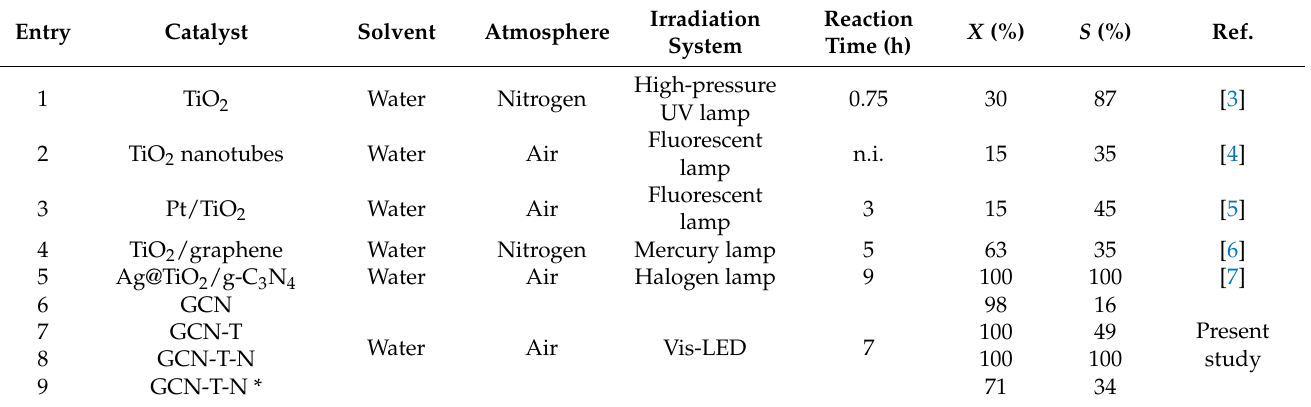
Table 2. A review of the heterogeneous photocatalytic synthesis of vitamin B3 (VB3) through the conversion of 3-pyridinemethanol